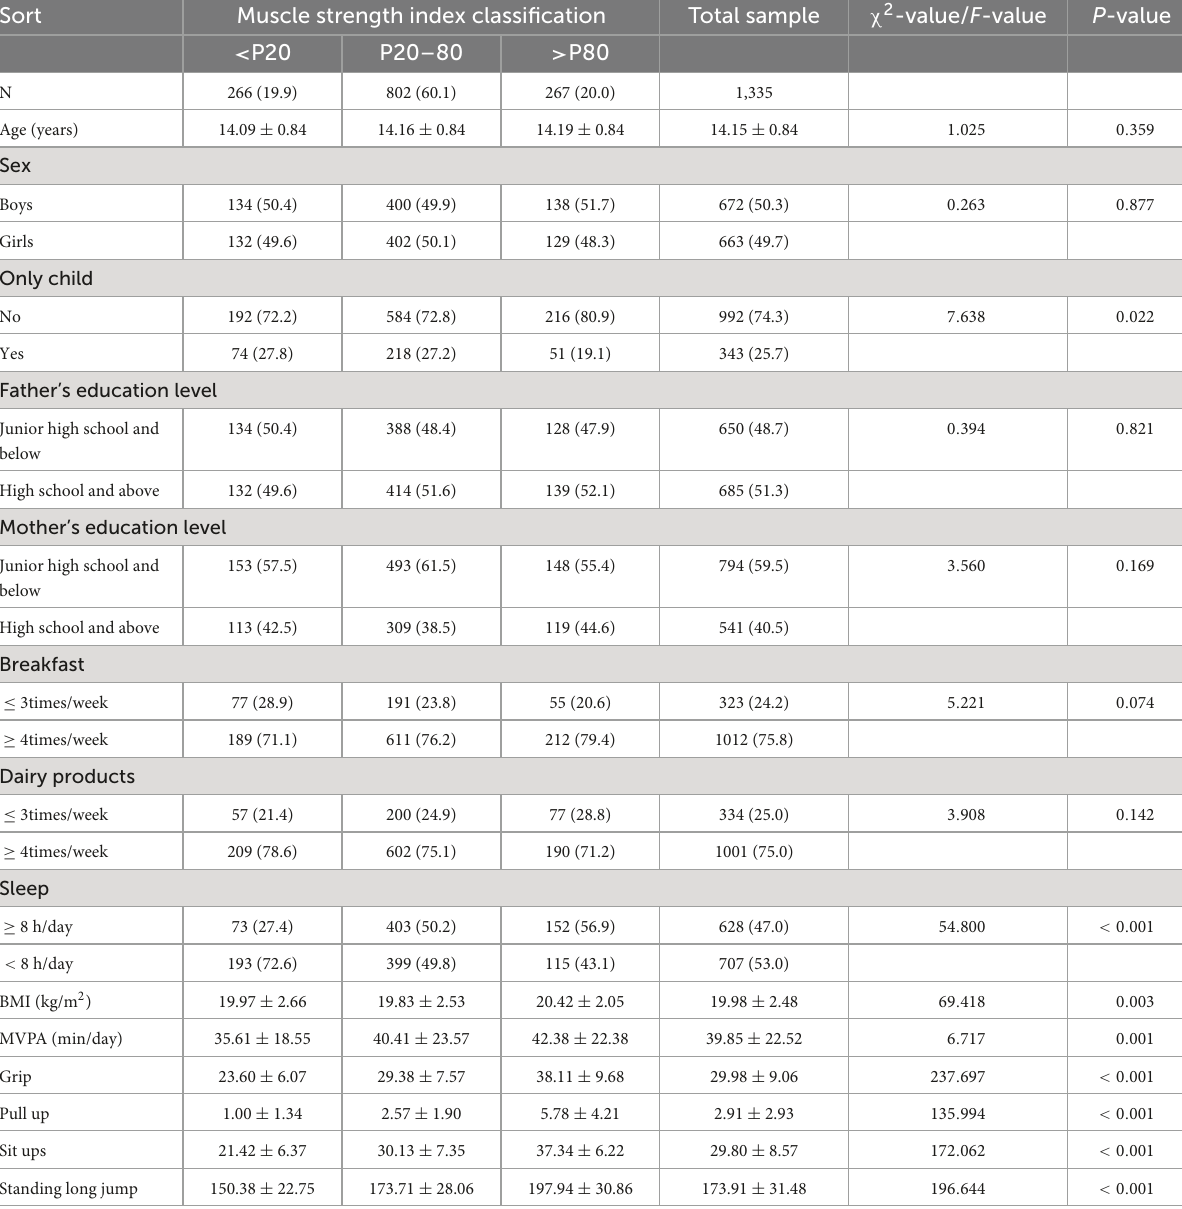
TABLE 1 Comparison of muscle strength index among different categories of children and adolescents in rural areas of